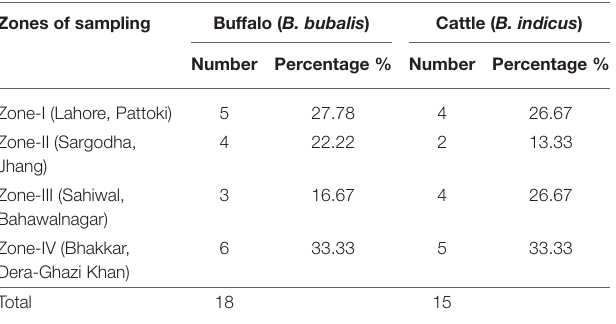
TABLE 2 | Distribution of C. perfringens in buffalo and cattle from four sampling zones of Punjab province in Pakistan. Zones of